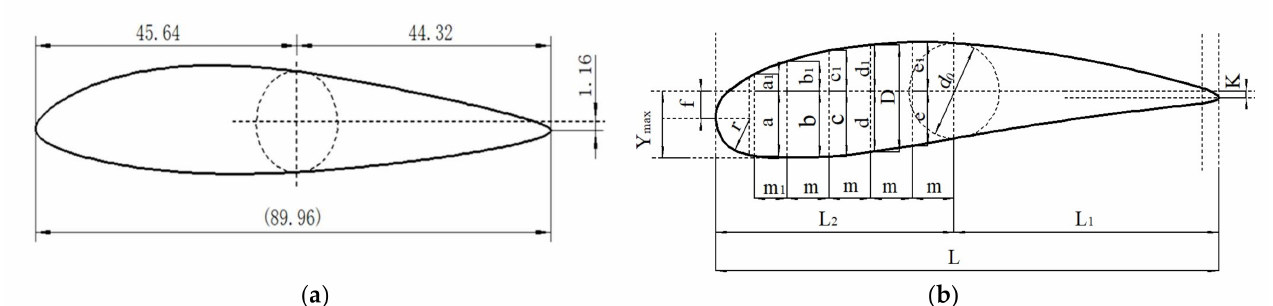
Figure 1. Schematic diagram of the modified anterior and posterior guide vane airfoils. ( a ) Prototype movable guide vane wing type (Unit is mm). ( b ) Modified movable guide vane wing type.